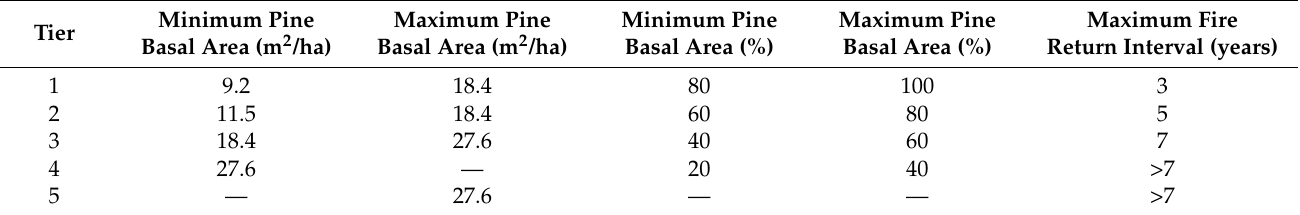
Table 1. Parameters used in the case study analysis assigning ecological condition class values to the forests of the Talladega National Forest in Alabama,